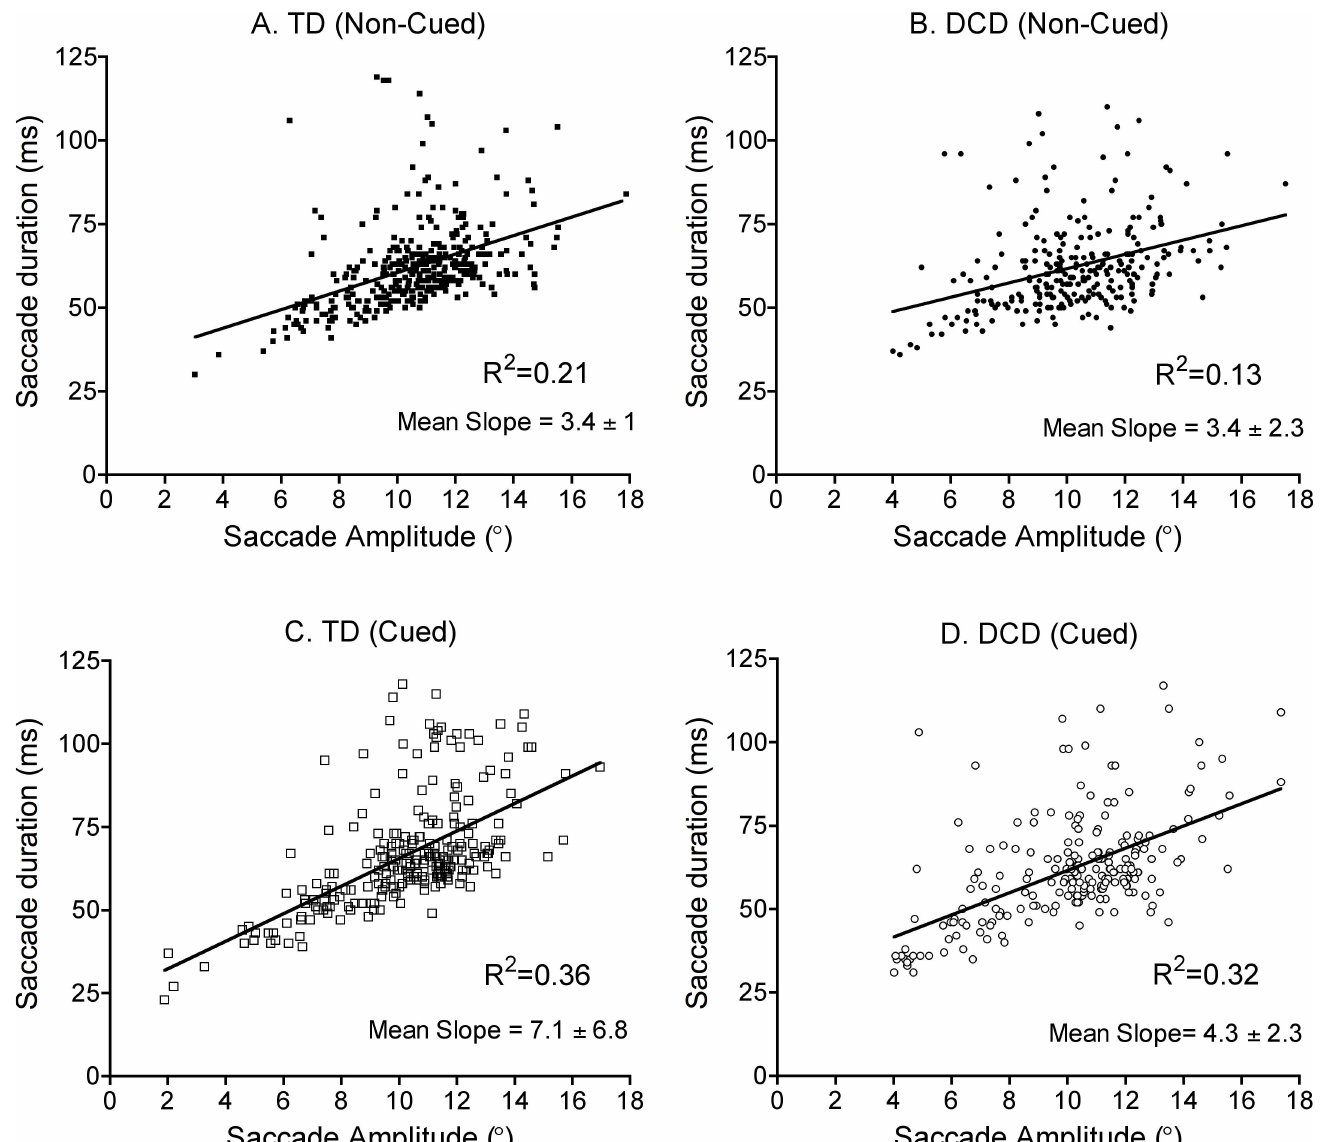
Fig 2. The reported data are for all saccades made within the trial that exceeded 2˚ in amplitude during the eye only (EO) task. Saccade duration and amplitude(main sequence)of TD children (A and C, left) and childrenwith DCD (B and C, right) during Non-Cued(A and B, top graphs) and Cued (C and D, lower graphs) conditions. The graph shows the relationshipbetween the saccade’s duration and corresponding amplitude. These included anticipatory saccades from the Cued conditions as these occurred in more than 50% of trials in the DCD group. All graphs show significant R 2 values, which reveal a linear relationshipbetween these saccade parametersin both groups and show the mean slopes obtained from each participant’s main sequence.Comparisons between group and conditiondid not reveal significant